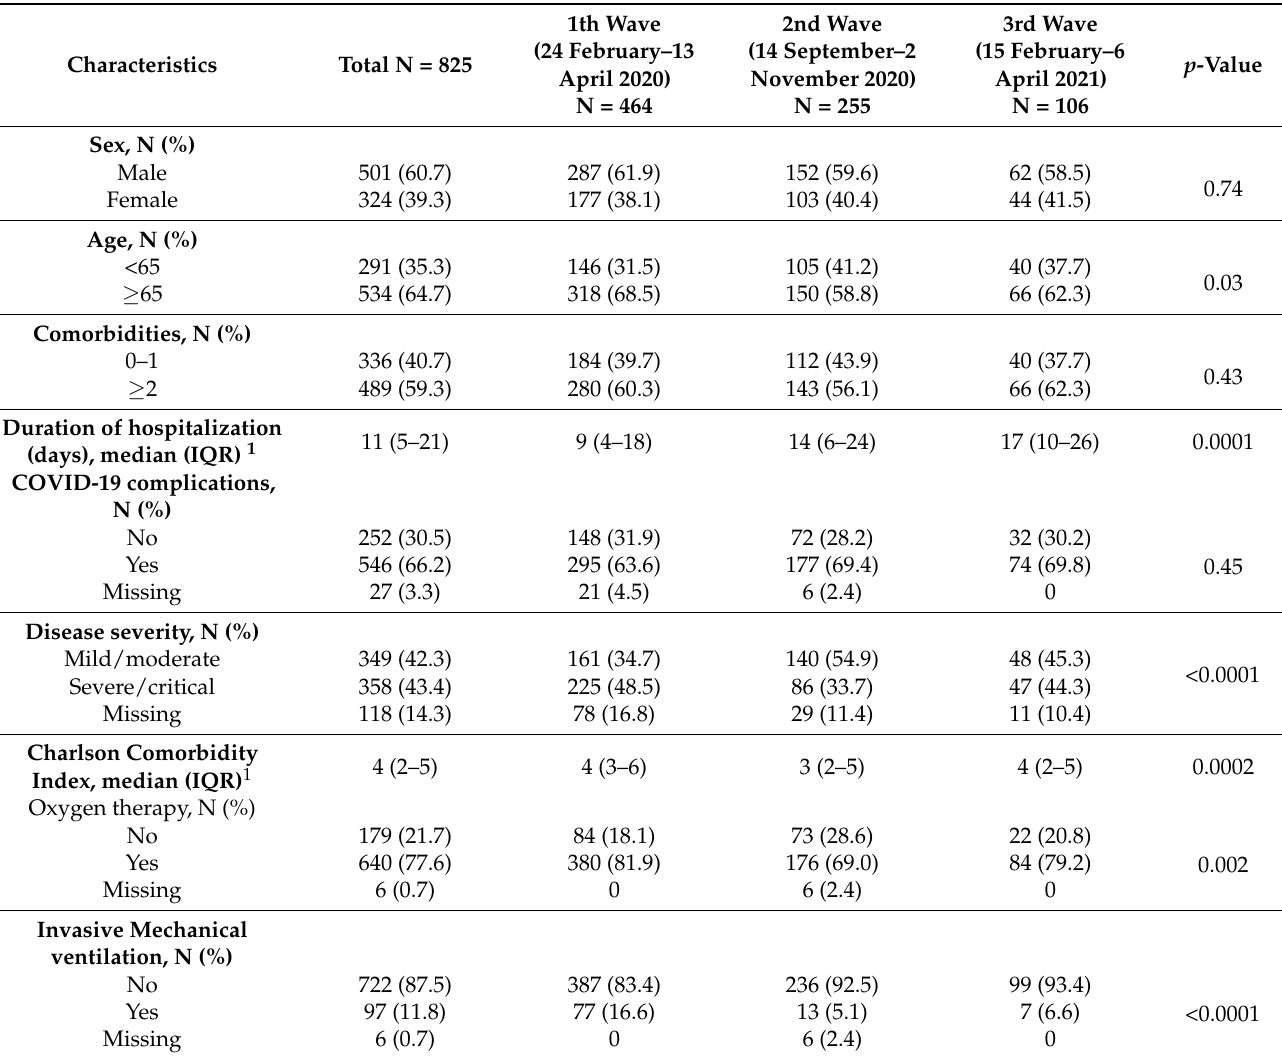
Table 1. Demographic and clinicopathological characteristics of the patients hospitalized at Alessan- dria’s hub hospital during the first fifty days of the three COVID-19 pandemic waves.